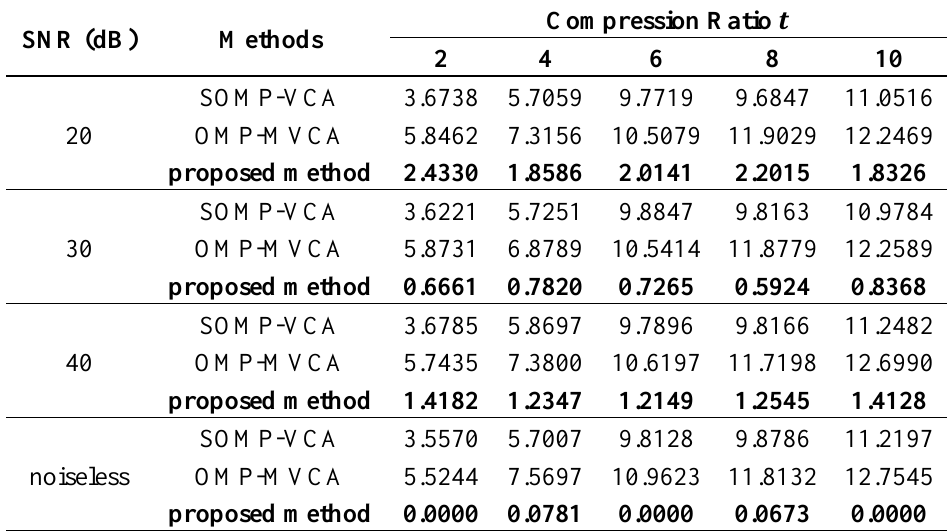
Table 5. Urban HSI: the standard deviations of rmsSAE of the proposed method, SOMP-VCA method and OMP-MVCA method under different noise